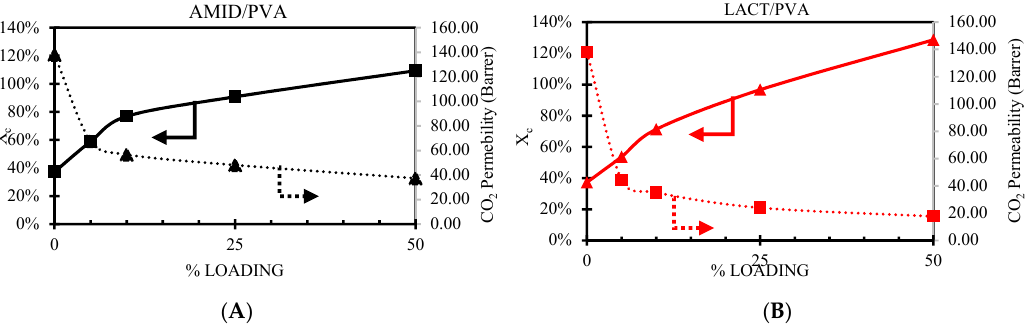
Figure 12. Effect of CO 2 permeability, dotted line, and degree of crystallinity ( X c ), solid line, versus nanoparticle loading. Amidino POSS ® /PVA ( A ), Lactamide POSS ® /PVA ( B ).